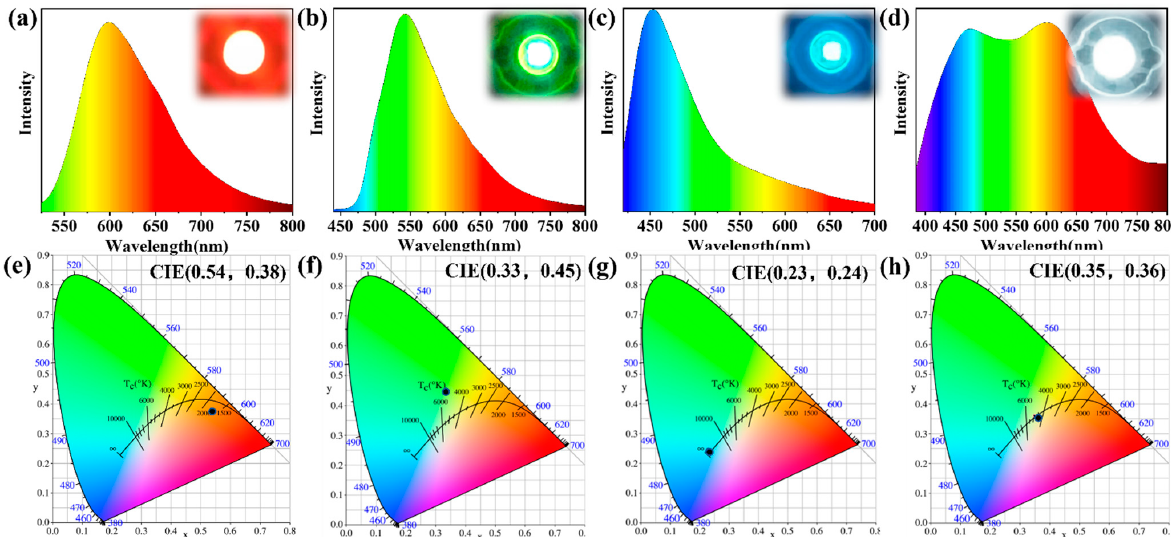
Figure 7. Corresponding emission spectra of ( a ) red (R)-LEDs, ( b ) green (G)-LEDs, ( c ) blue (B)-LEDs, and ( d ) W-LEDs (LED illustrations). CIE colour coordinates of ( e ) R-LEDs, ( f ) G-LEDs, ( g ) B-LEDs, and ( h ) W-LEDs.